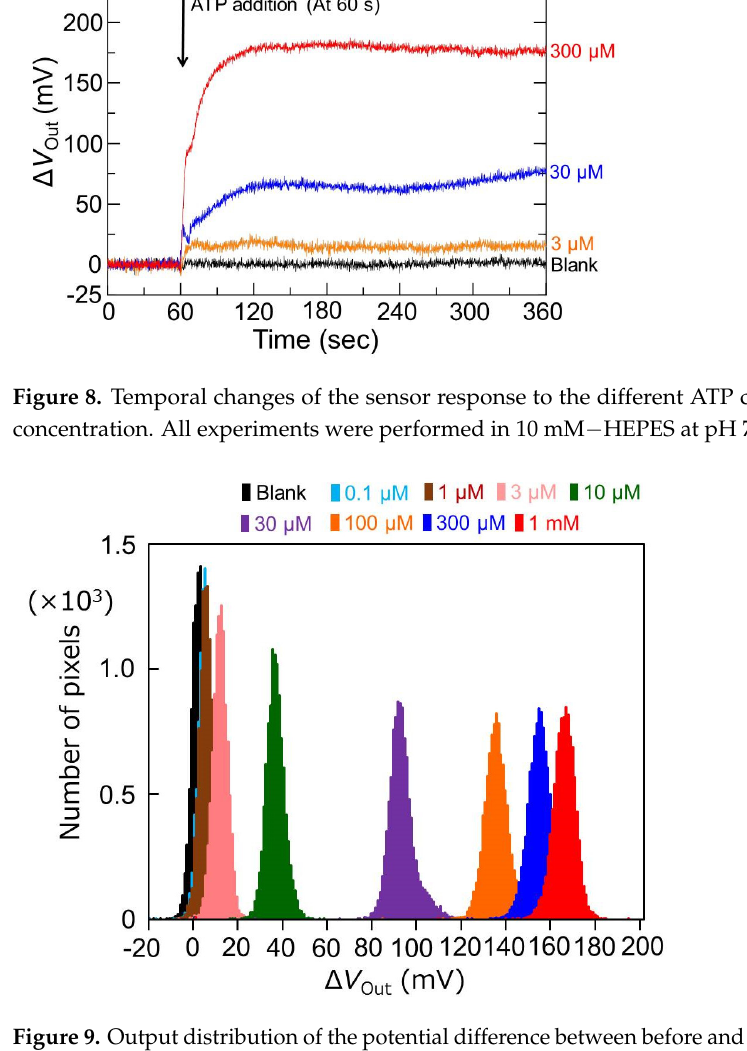
Figure 9. Output distribution of the potential difference between before and after the addition of ATP.